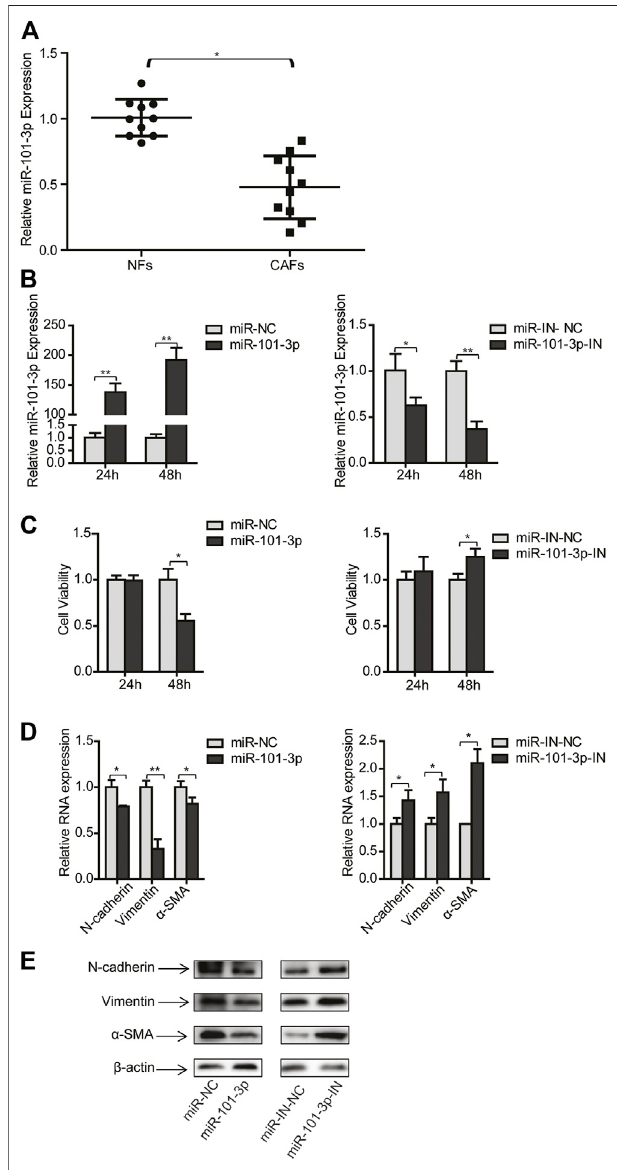
FIGURE 2 | MiR-101-3p suppressed CAFs activation. (A) MiR-101-3p expression in NFs and CAFs was detected by qPCR ( n (cid:2) 10). CAFs were transfected with 100 nM of miR-101-3p mimics or inhibitors. (B) MiR-101-3p expression in CAFs was detected by qPCR. (C) Cell viability was examined by CCK-8 kit. (D) Gene expression was detected by qPCR. (E) Gene expression was detected by Western blots. Values represent the mean ± SD from 3 independent experiments. * p < 0.05; ** p < 0.01; *** p <